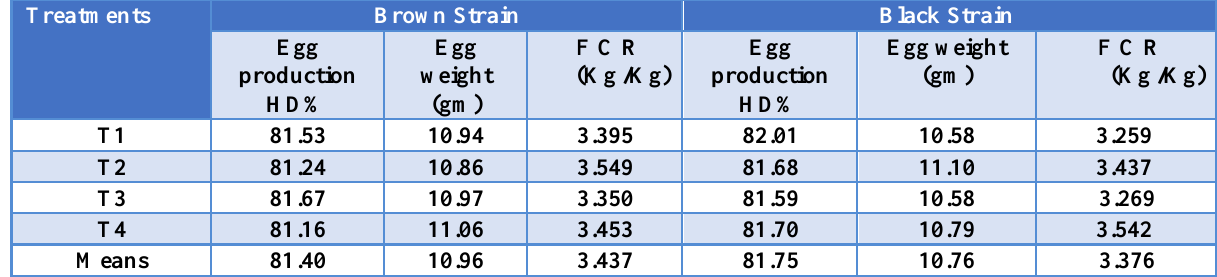
Table, 4: Effect of treatments egg production, egg weight , feed convertion ratio.